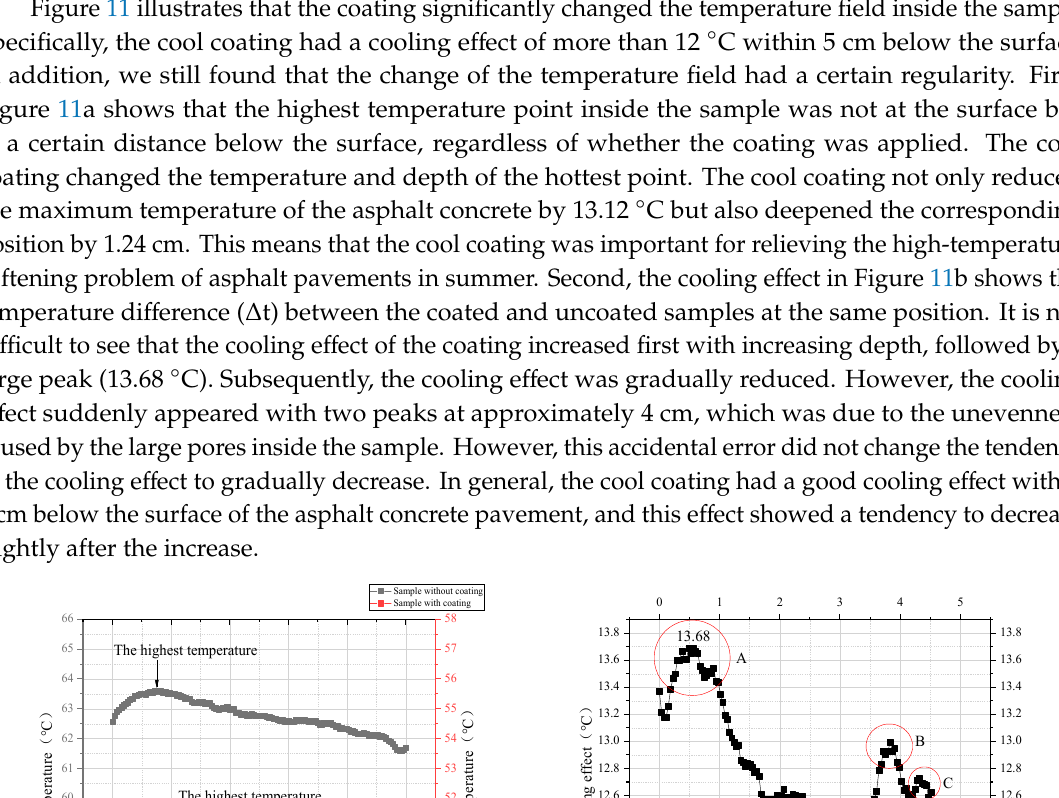
Figure 10. Temperature fields of samples inside an ( a ) uncoated sample and a ( b ) coated sample.